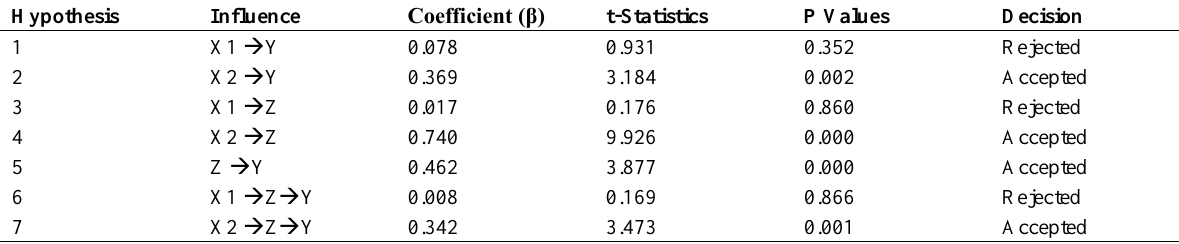
Table 7 : Results of Hypothesis Test for Direct and Indirect